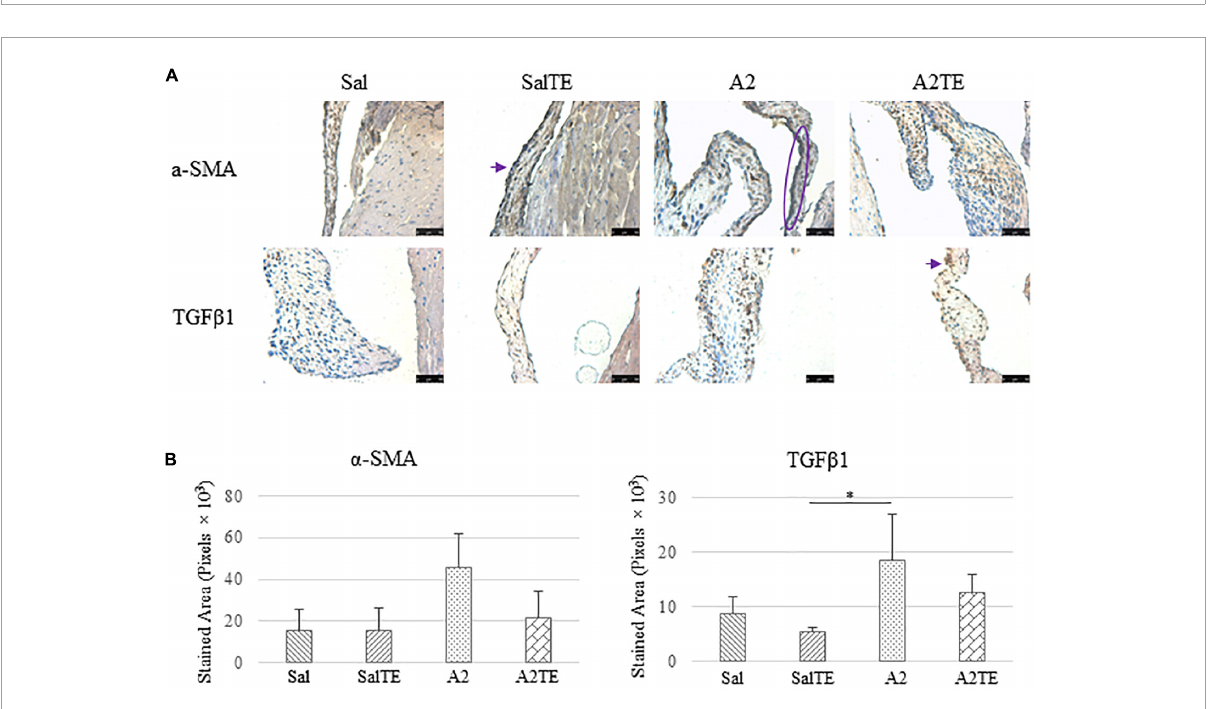
FIGURE9 (A) Investigation of mitral valve VIC activation by IHC examinations on α -SMA and TGF β 1 in reversal study. Major positive IHC stains were highlighted by circles and arrows. Scale bar: 50 µ m. (B) Quantification of their expression determined by total stained area in pixels that measured from 4 biological replicates in MATLAB. Asterisk indicates significant difference ( p <